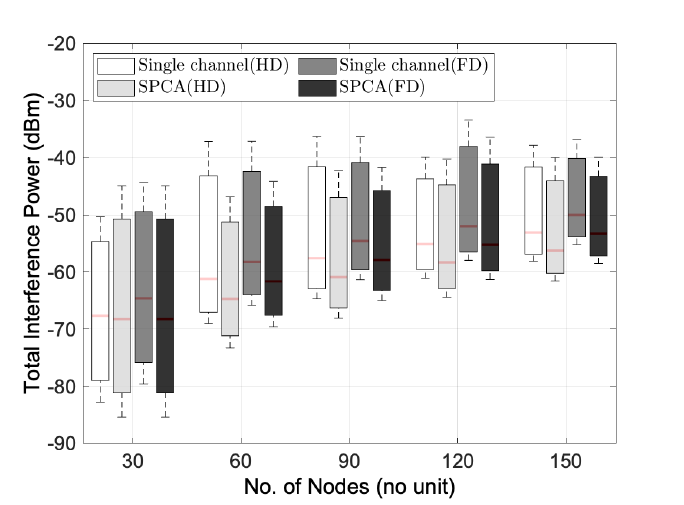
Figure 3. Performance comparison between HD and FD transmission modes for the distribution of total interference power versus the number of nodes.